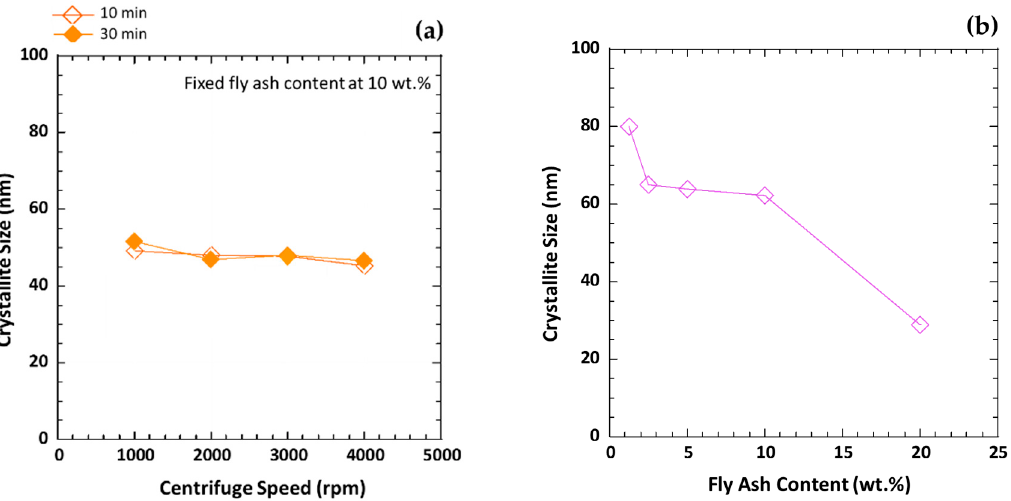
Figure 8. Average crystallite sizes of calcite (104) contained in cenospheres collected by ( a ) centrifugal method at different centrifugal speeds and times using 10 wt.% fly ash content (1:10 fly ash-to-medium ratio) and ( b ) sink-float method at different fly ash contents and fixed soaking time at 48 h.